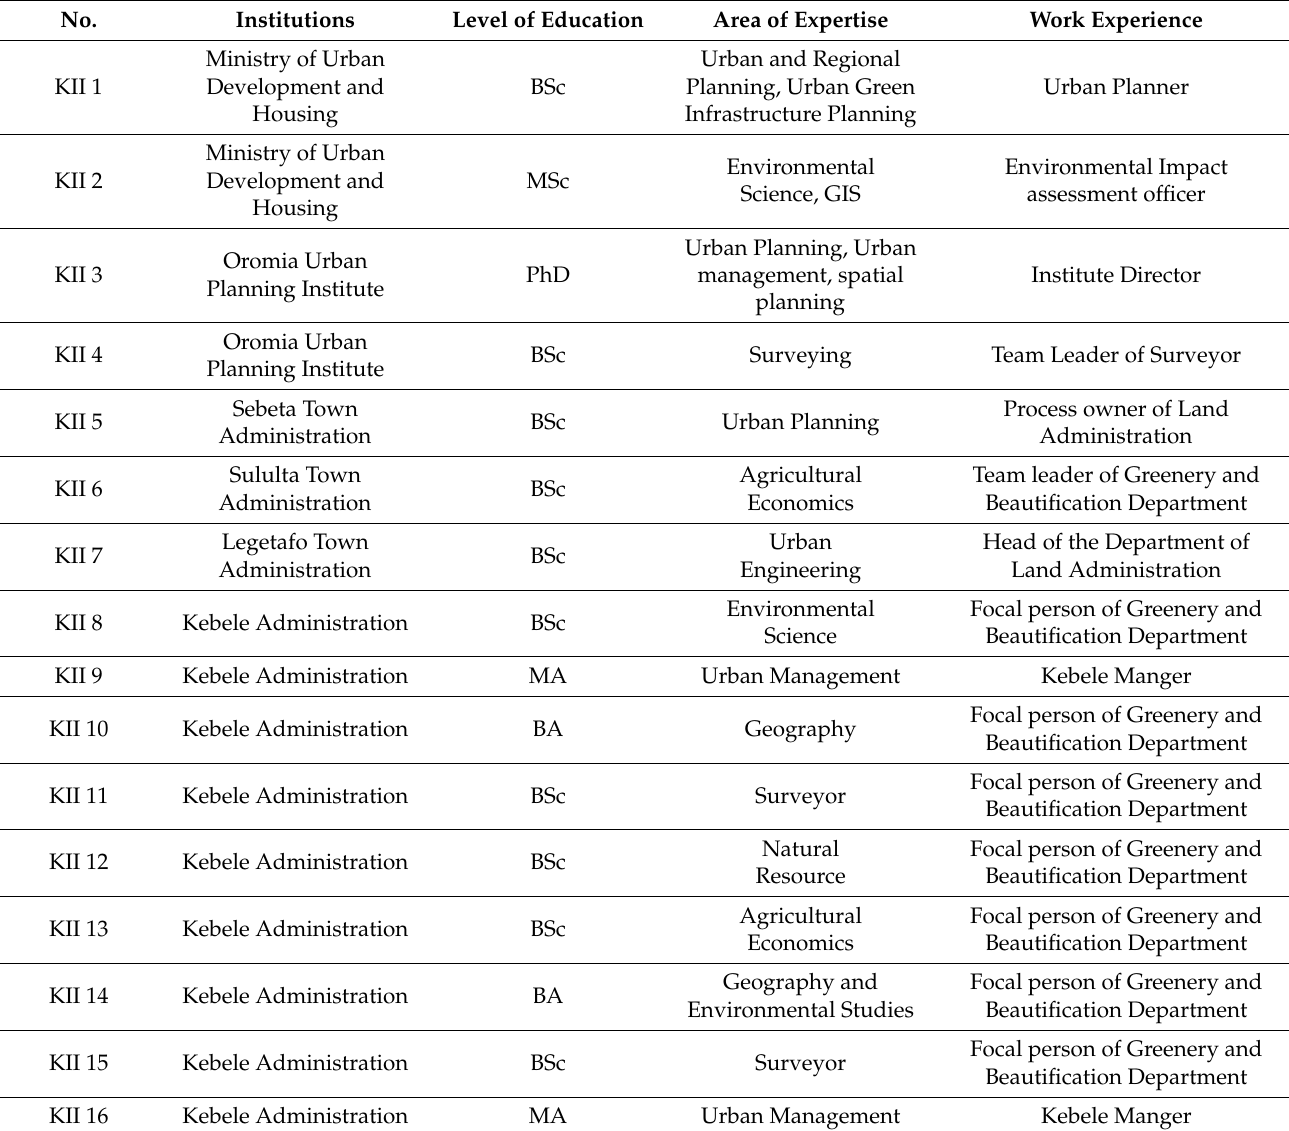
Table 2. Level of education, area of expertise, institutions and work experience of interviewed key